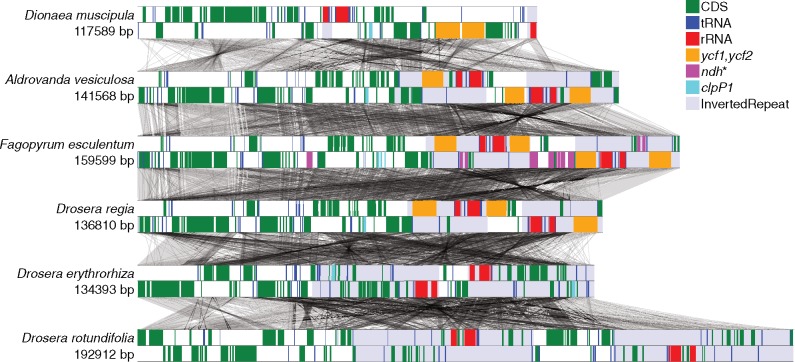
—Physical maps of the plastid genomes of Droseraceae compared with that of Fagopyrum esculentum. The genomes are drawn to scale. Different gene classes and the inverted repeats are indicated by colored bands. Gray lines connecting adjacent genomes indicate synteny; each line represents an indel-free sequence alignment of >40 bp in length and with >50% matching bases. The genomes have been arranged to display synteny conservation as much as possible, that is, the most divergent genomes have been placed at the top and bottom.